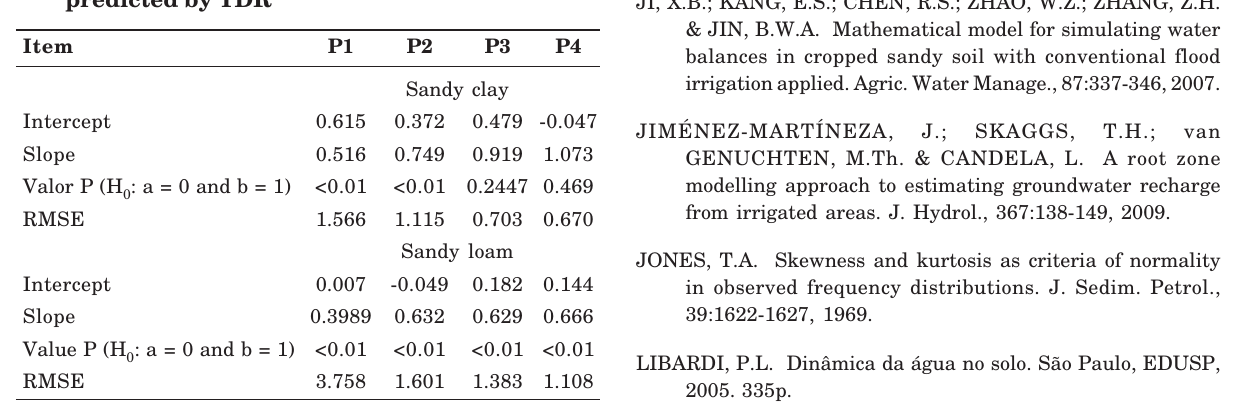
Table 3. Statistics for the regression between the percolation levels observed in lysimeters and predicted by